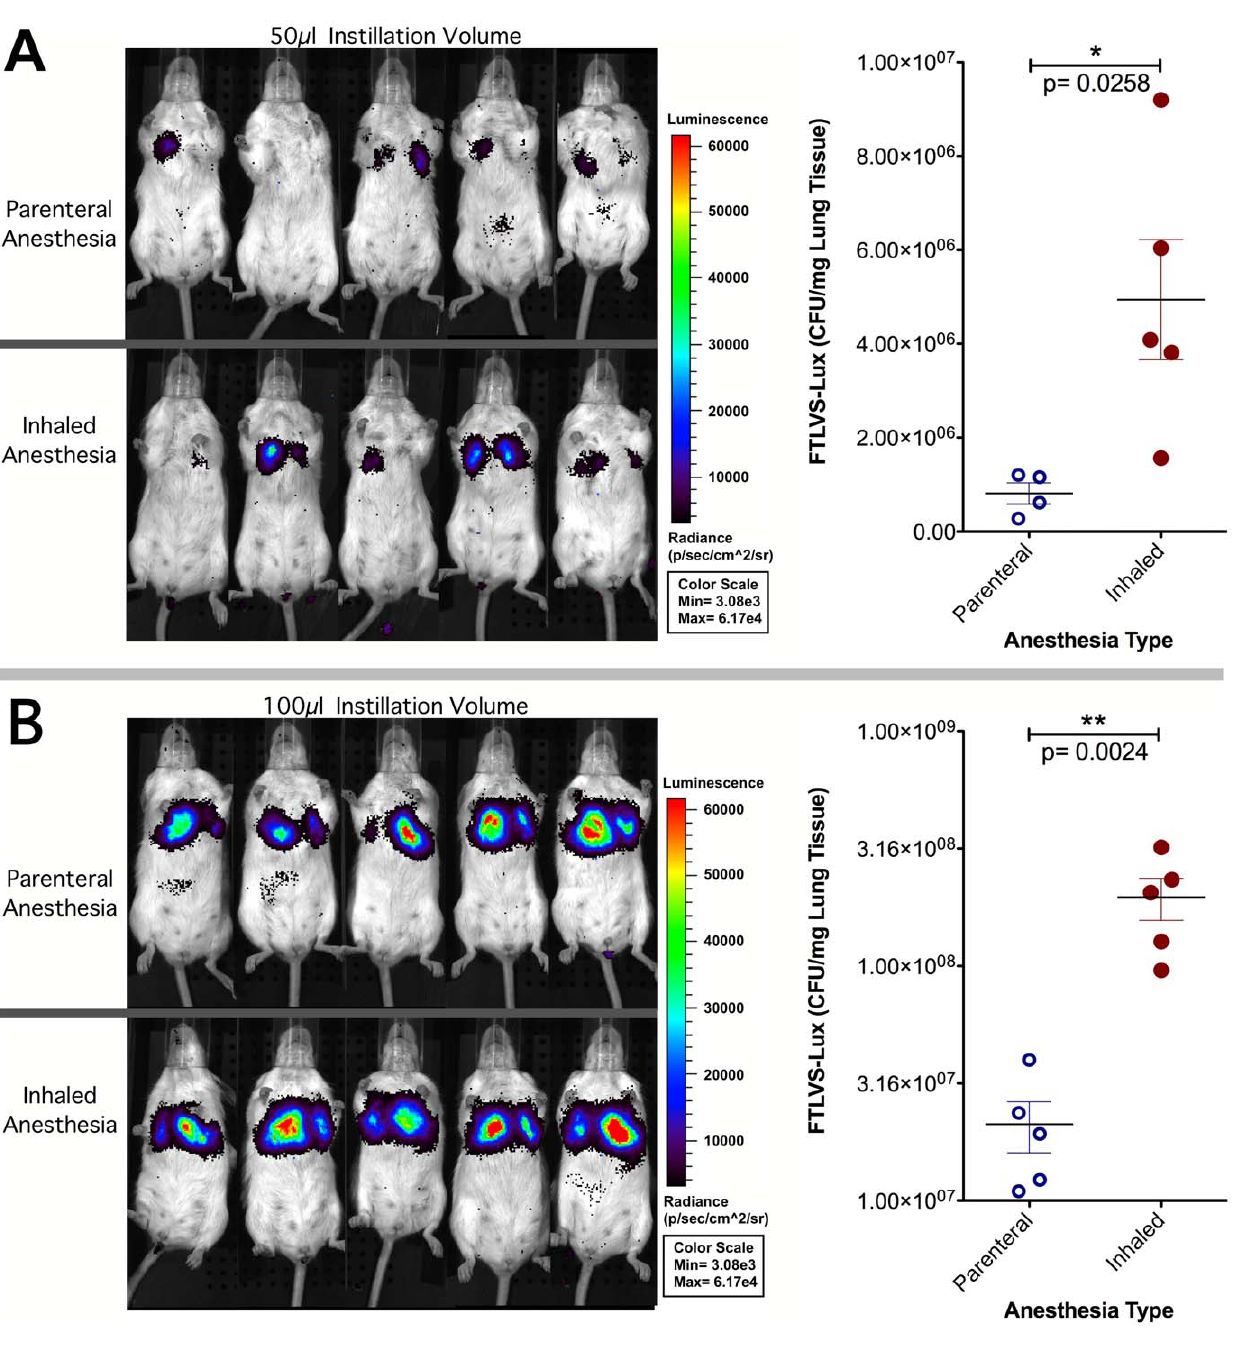
Figure 4. Pulmonary delivery of FTLVS-lux was more efficient under inhaled vs. parenteral anesthesia. BALB/c mice (5/group) were anesthetized using either inhaled isoflurane or parenterally-administered ketamine/xylazine and then challenged with either 1 6 10 5 CFU FTLVS-lux in a volume of 50 m l ( Panel A ) or 1 6 10 6 CFU FTLVS-lux in a volume of 100 m l ( Panel B ). Dissemination of FTLVS was monitored 24 hrs later using an IVIS Spectrum whole animal imaging system. Lungs were collected after imaging was completed for bacterial burden determination via dilution plating. All IVIS images were normalized to reflect photons per second per cm ‘ 2/sr. Statistical analyses were performed using the student t test.